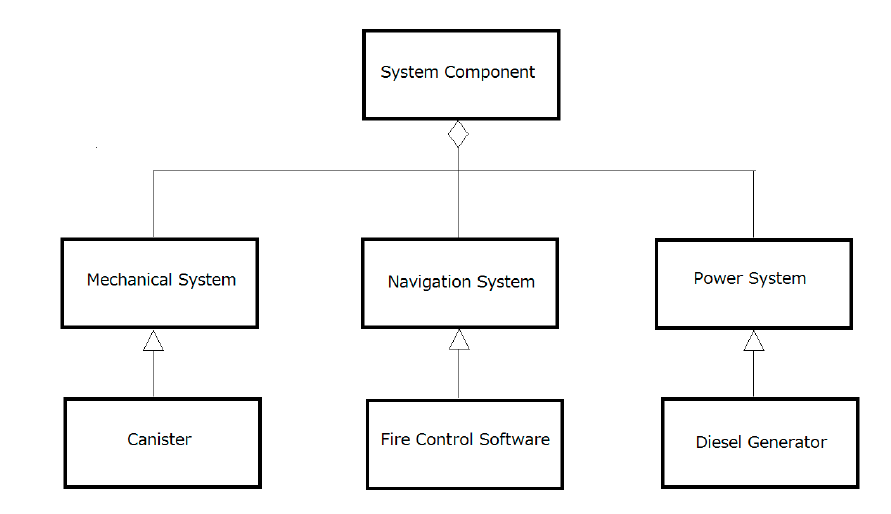
Figure 1. Illustrate the simplified modeling of the Multiple Launch Rocket System (MLRS) system with UML. This simple modeling system is done by capturing the related information concern, which not intended for use as database